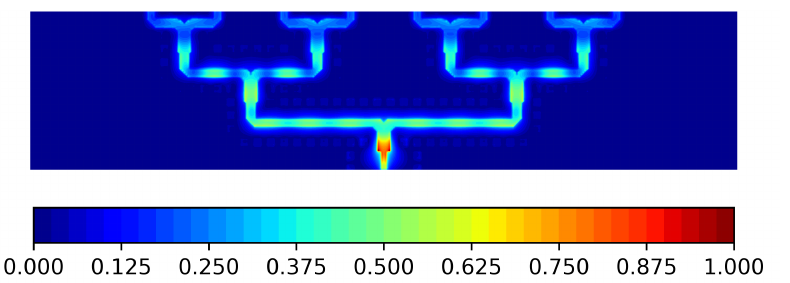
Figure 8. Magnitude of the normalized E z at f 0 = 31 GHz shown in the air gap of the